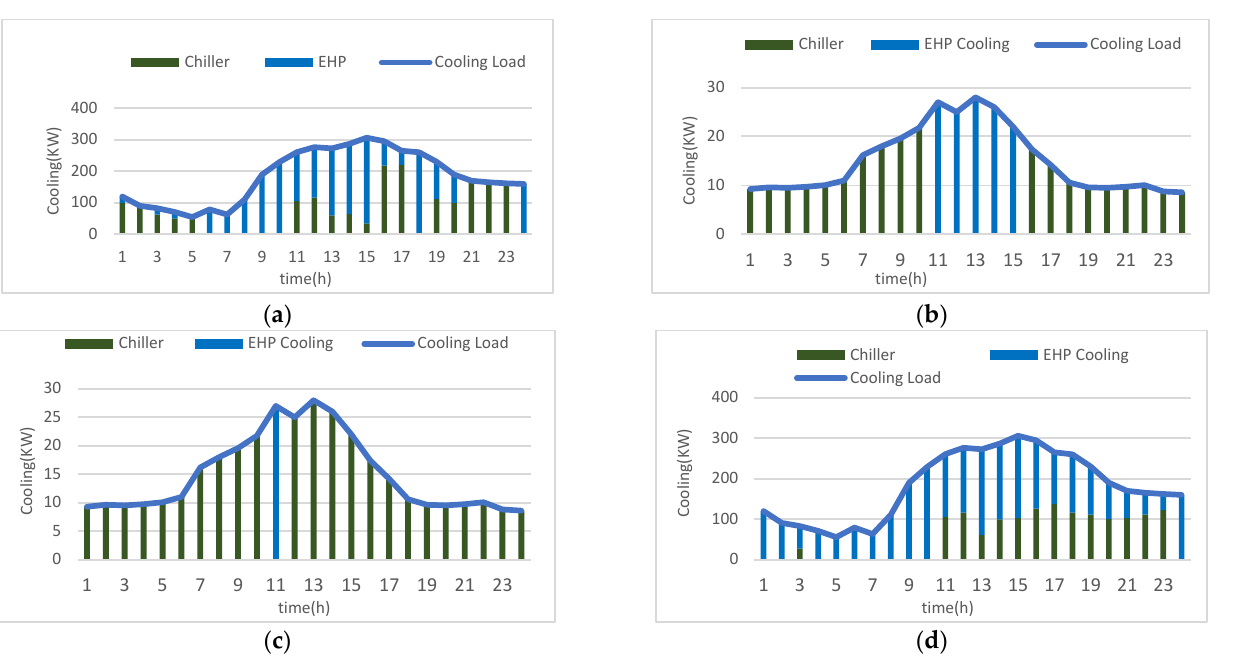
Figure 9. Optimal hourly Cooling demand balance ( a ) scenario 1 ( b ) scenario 2 ( c ) scenario 3 ( d ) scenario 4.